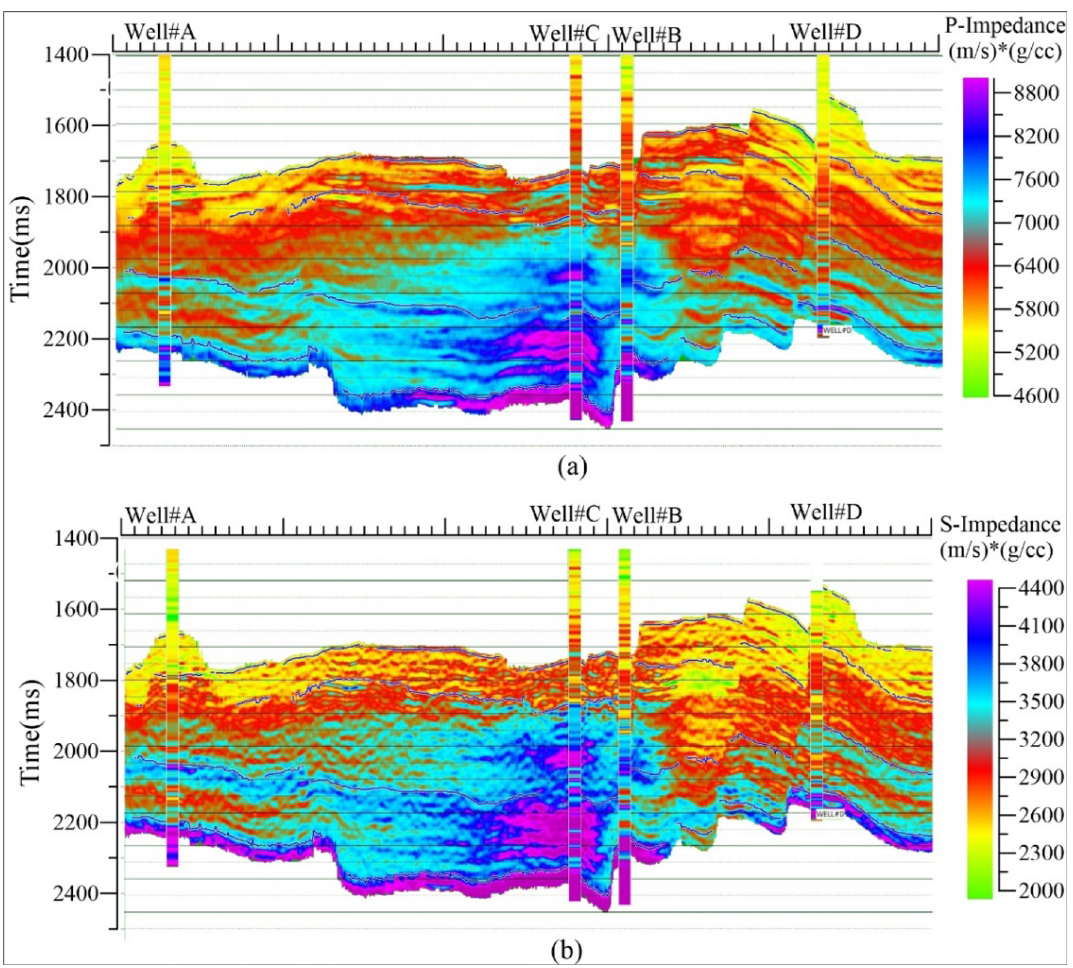
Figure 3. An arbitrary line of SPSI results along with well locations: ( a ) acoustic impedance, ( b ) shear impedance.